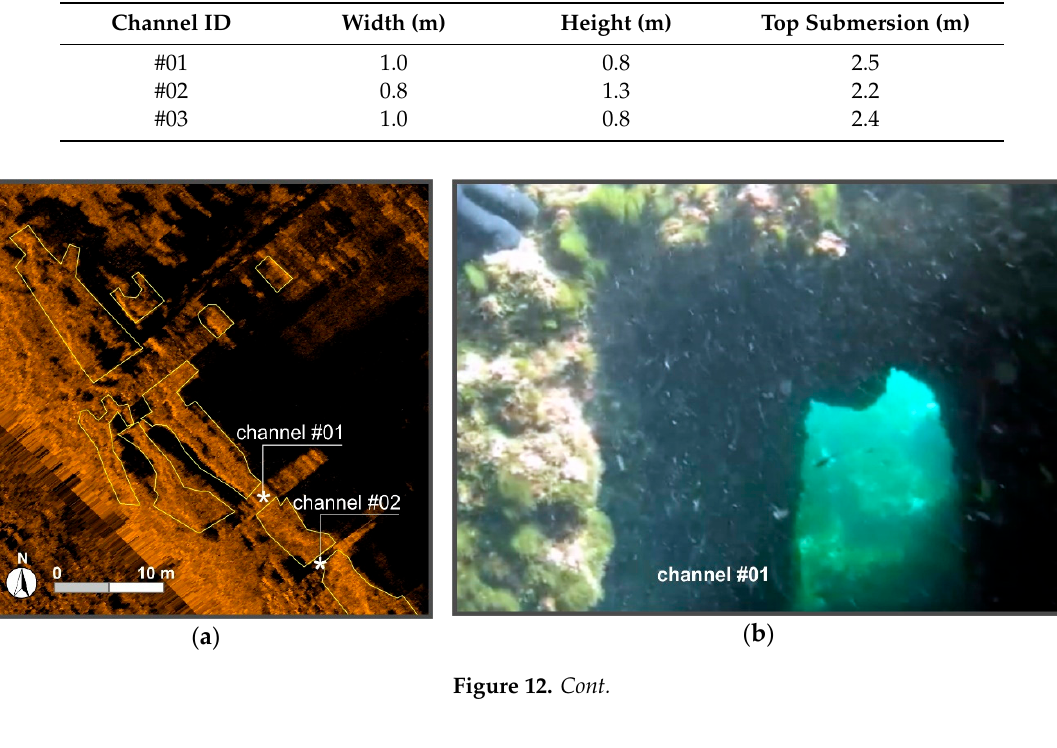
Figure 11. Map of the SSS mosaic archaeological interpretations. Table 2. Channel dimensions from direct measurements.